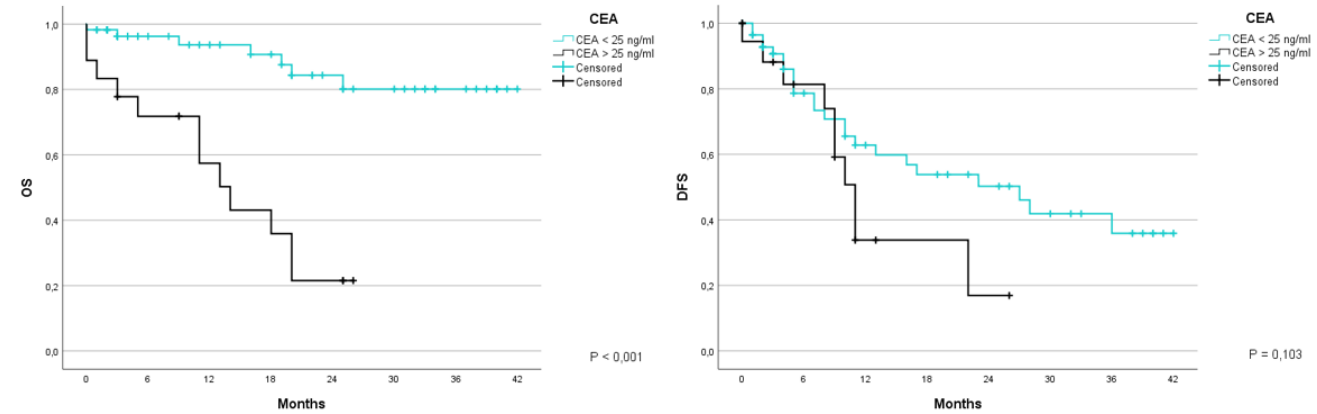
Figure 6. Kaplan-Meier Curve for OS and DFS in patients who underwent liver resection for CRLM stratified according whether the patient had adjuvant chemotherapy or not: Overall Survival; DFS: Disease Free Survival; CRLM: Colorectal liver metastasis; CHT: chemotherapy. Comparing the type of surgery technique chosen, the patients who were operated with a laparotomic hepatic resection had a global survival at 1 and 3 years of 84.8% and 64.7% respectively with an average of 31.7 months (CI 95% 27.7 – 35.8months); while those who underwent a laparoscopic procedure had an OS of 75% and 50%, with an average of 25.3 months (CI 95% 10.3 – 40.2) ( p = 0.570). Moreover, DFS in the same period was 54.7% and 26.2% for the first group with an average of 21 months (CI 95% 16.5 – 25.5), and 66.7% for the second group, with an average of 29 months (CI 95% 11.4 – 46.6) ( p = 0.228) (Figure 7).